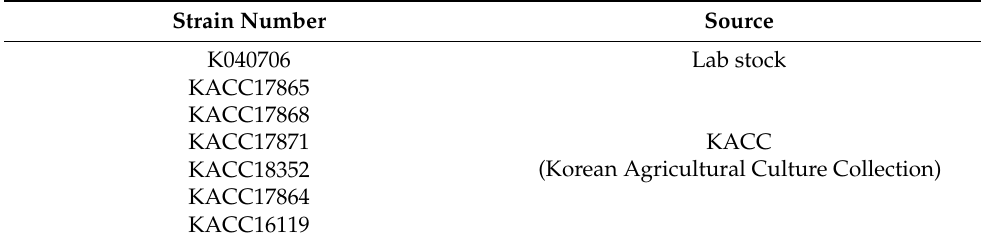
Table 1. Lactilactobacillus sakei strains used in this